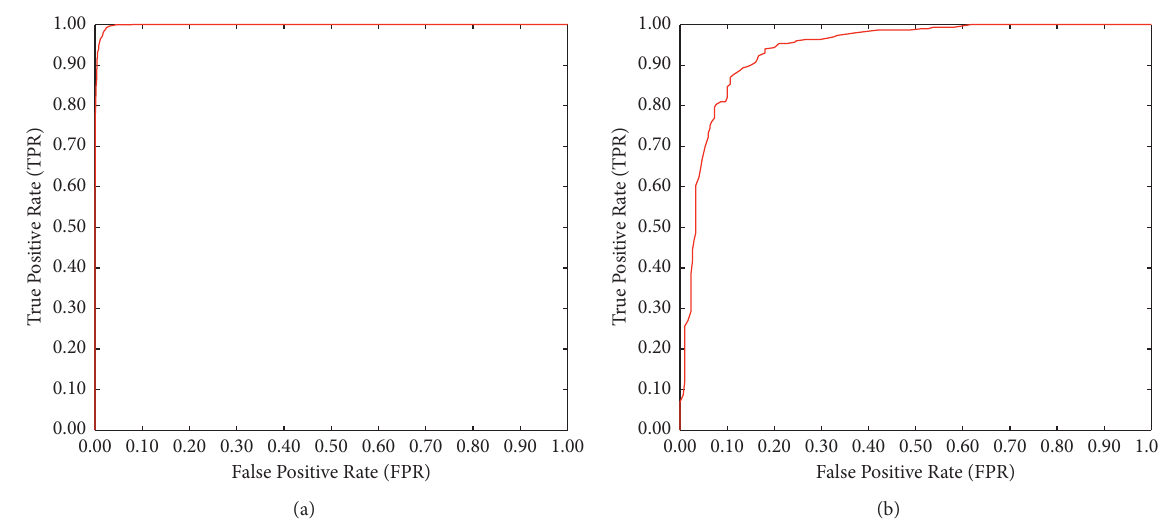
Figure 12: ROCs of RFC: (a) training phase and (b) testing